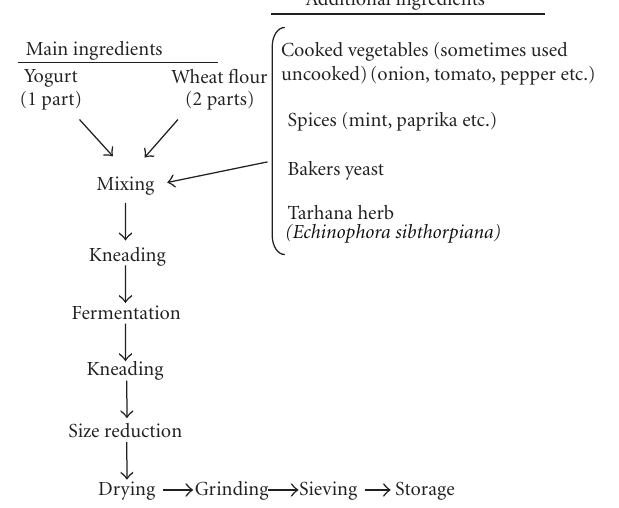
Table 1: Number of samples collected according to